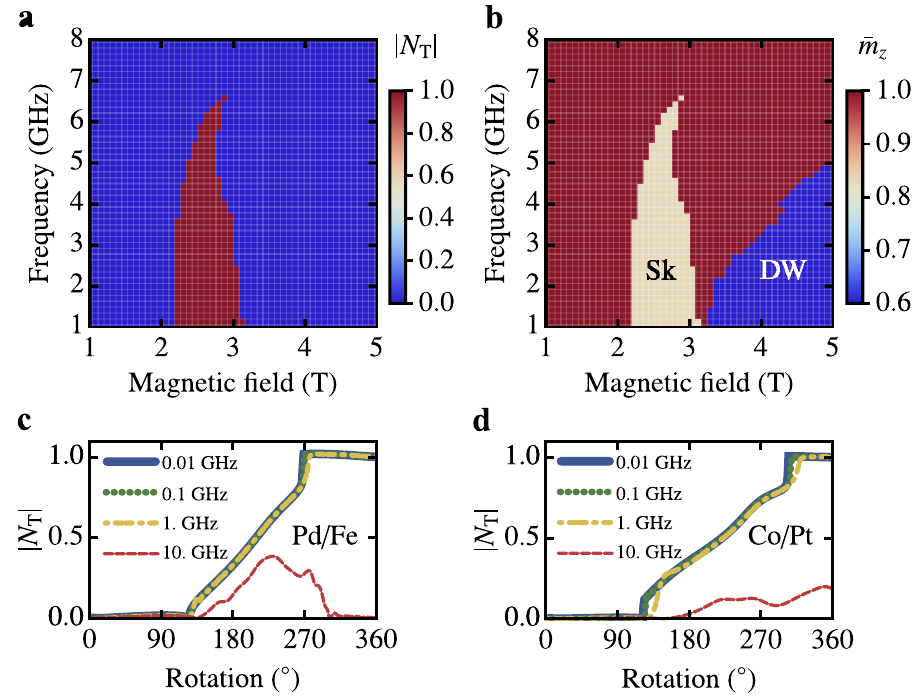
Figure 2. Quasiparticle creation due to a single rotation of a magnetic field localized at the sample edge. ( a , b ) Parameter space diagrams for a single field rotation and subsequent system relaxation. Shown is the absolute value of the topological charge | N T | ( a ), and the vertical magnetization averaged over the sample ( b ) as a function of the frequency and amplitude of the time-dependent driving field. The excited area at the left boundary is 7 c × 24 c , and the damping parameter α = 0.1 . ( c , d ) Absolute value of the topological charge as a function of the rotational phase of the local field for Pd/Fe/Ir(111) ( c ) and Co/Pt ( d ). System size: 60 × 30 × 1 c 3 for ( a – c ) and 100 × 64 × 1 c Co3 for ( d ), with material parameters corresponding to Pd/Fe/Ir(111) ( a – c ) and Co/ Pt ( d ); c = 0.233 nm, c Co = 1